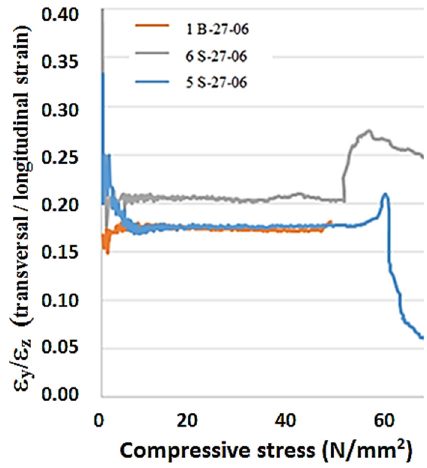
Figure 3. Poisson’s ratio as a function of compression.